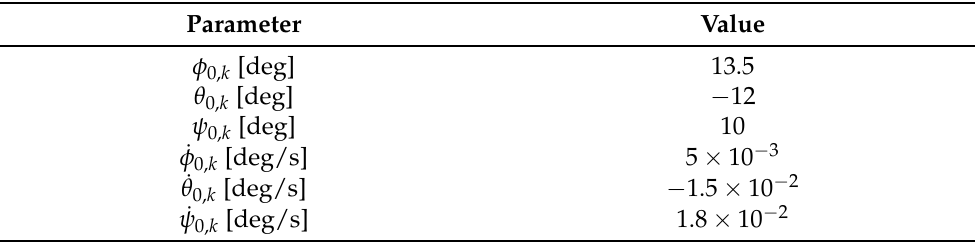
Table 2. Initial Euler angles and angle rates for the roto-translational maneuver, subscript k = 1, t denotes chaser 1 and target,